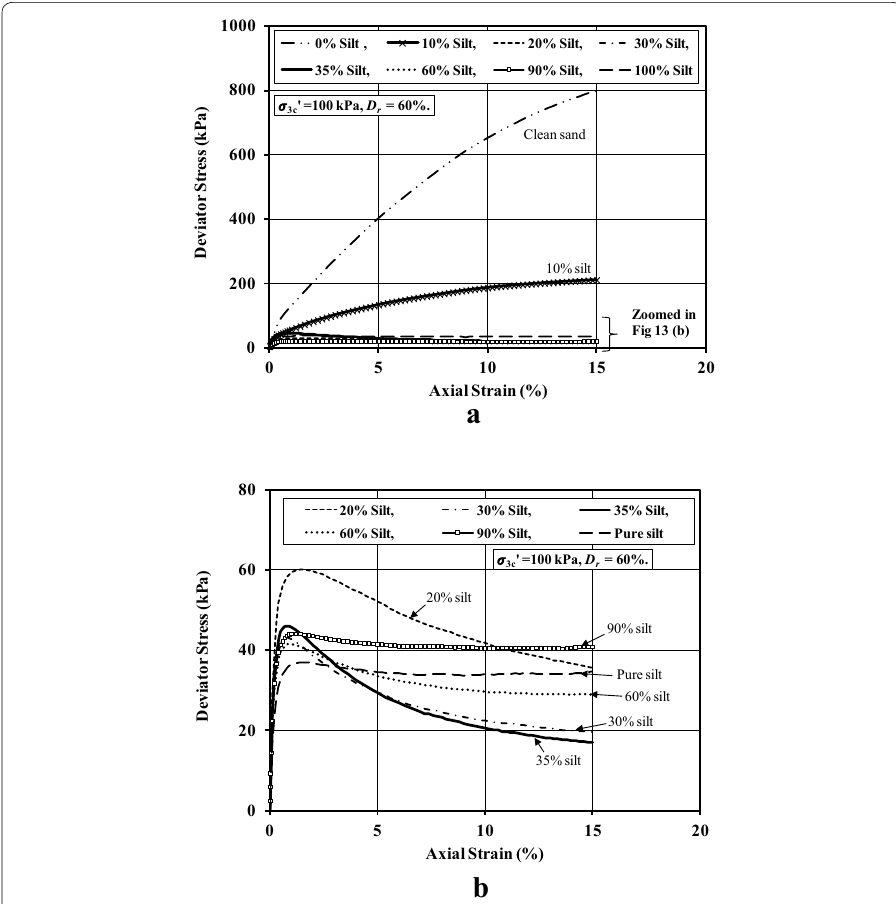
Fig. 13 Stress–strain relationship at 60% initial relative density; a silt content 0–100% and b silt content 20–100% silt